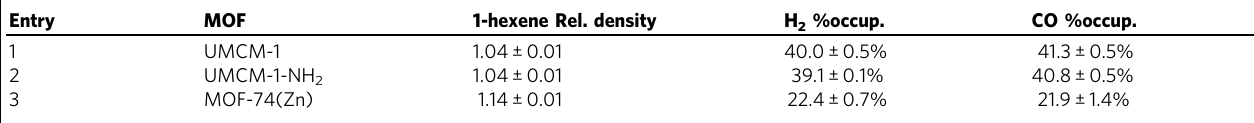
Table 2 Af fi nity of the different species with the frameworks is reported as percentage occupancy (%occup.) a .